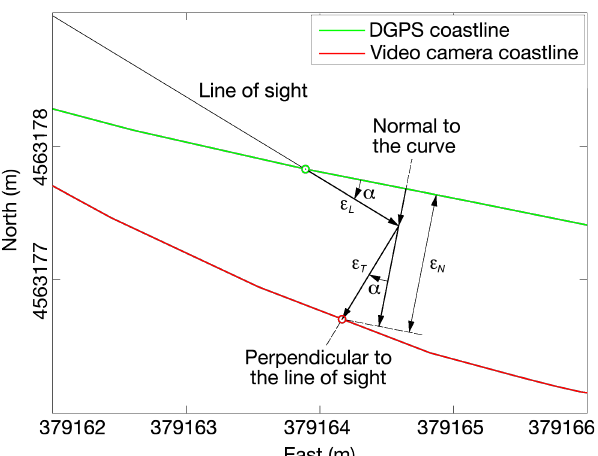
Figure 5. Scheme of the longitudinal and transverse error projections along the normal direction to the